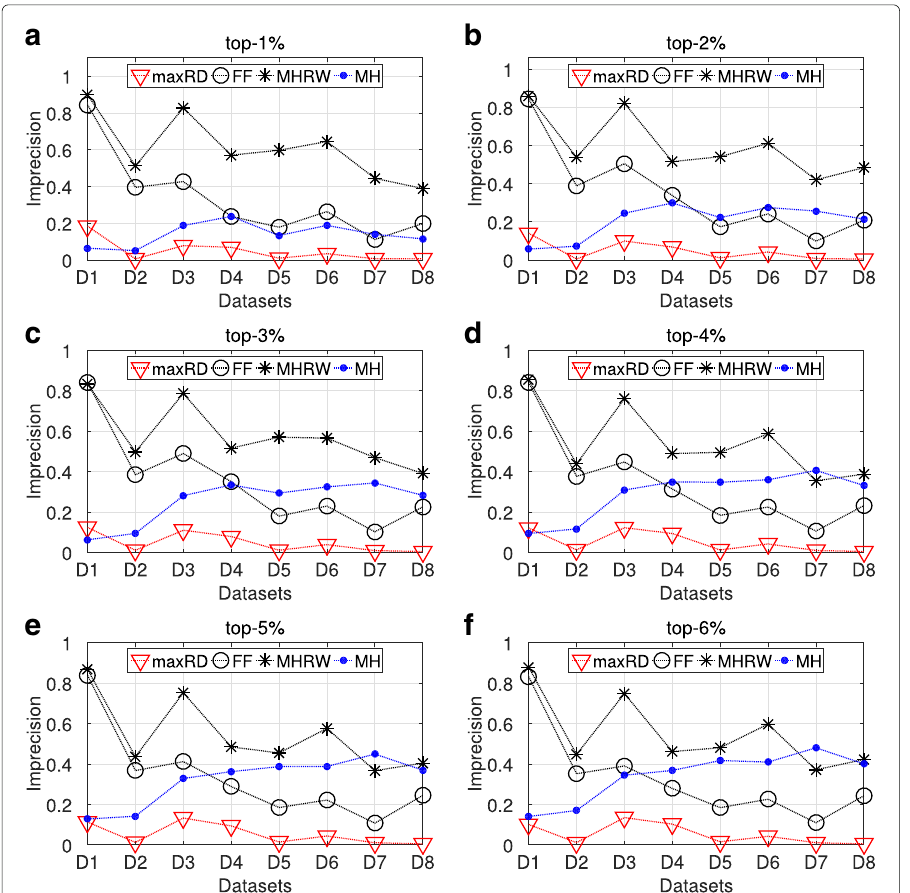
Fig. 7 Comparison of the sampling methods. SIR epidemic. a - f average imprecision values based on the degree centrality values, obtained from the 100 samples of each